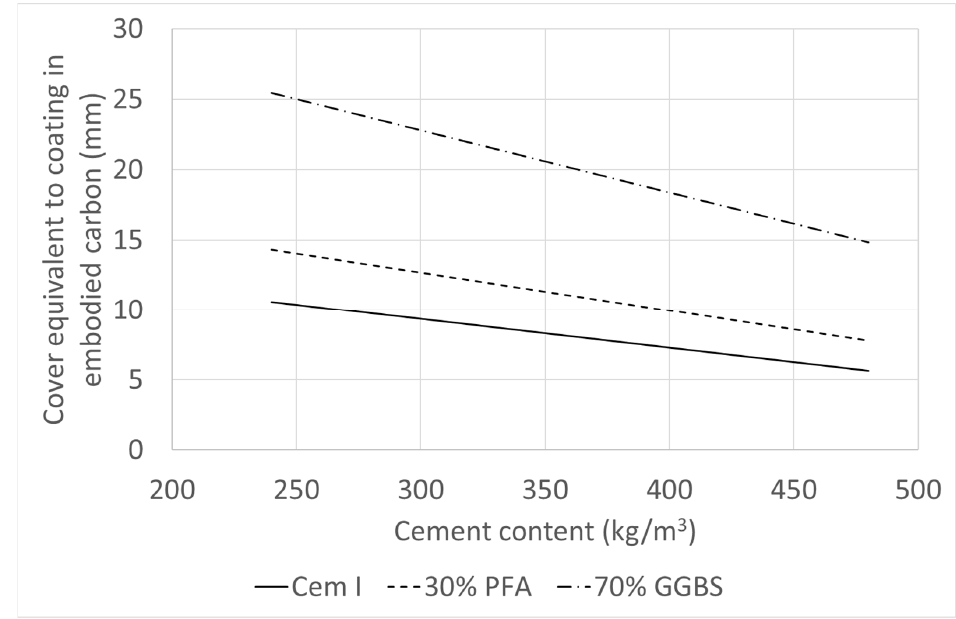
Figure 8. Cover equivalent (mm) to the embodied carbon in a coating.